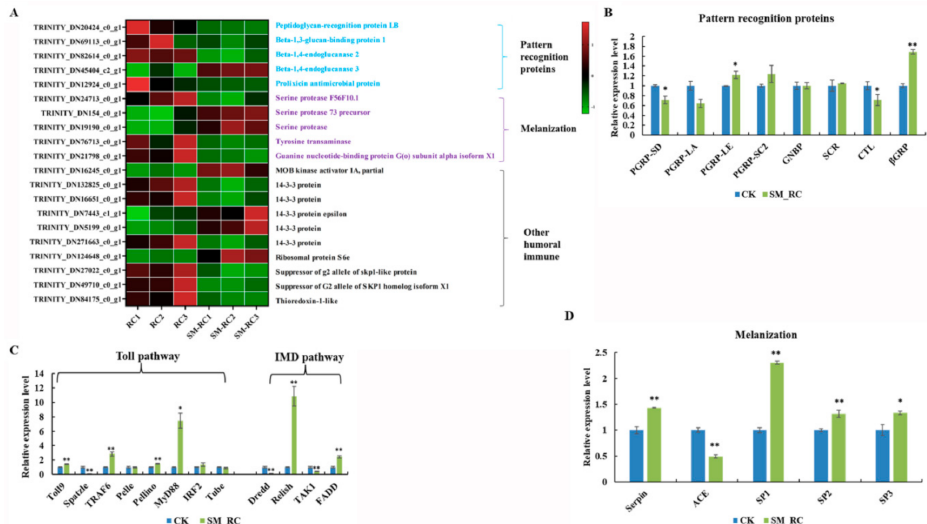
Figure 6. Changes of the humoral immunity-related genes of R. chinensis after infection with SM1. ( A ) Heatmap displaying the DEGs related to humoral immunity using sequencing data. RC1, RC2, and RC3: The control groups; SM_RC1, SM_RC2, and SM_RC3: R. chinensis groups infected with SM1. ( B ) Analysis of pattern recognition protein genes expression using qRT-PCR. ( C ) Analysis of the expression of genes related to the Toll and IMD pathways using qRT-PCR. ( D ) Analysis of the expression of genes related to the melanization pathway using qRT-PCR. The star symbols (* p < 0.05; ** p < 0.01) indicates statistical significance between the treatment and control